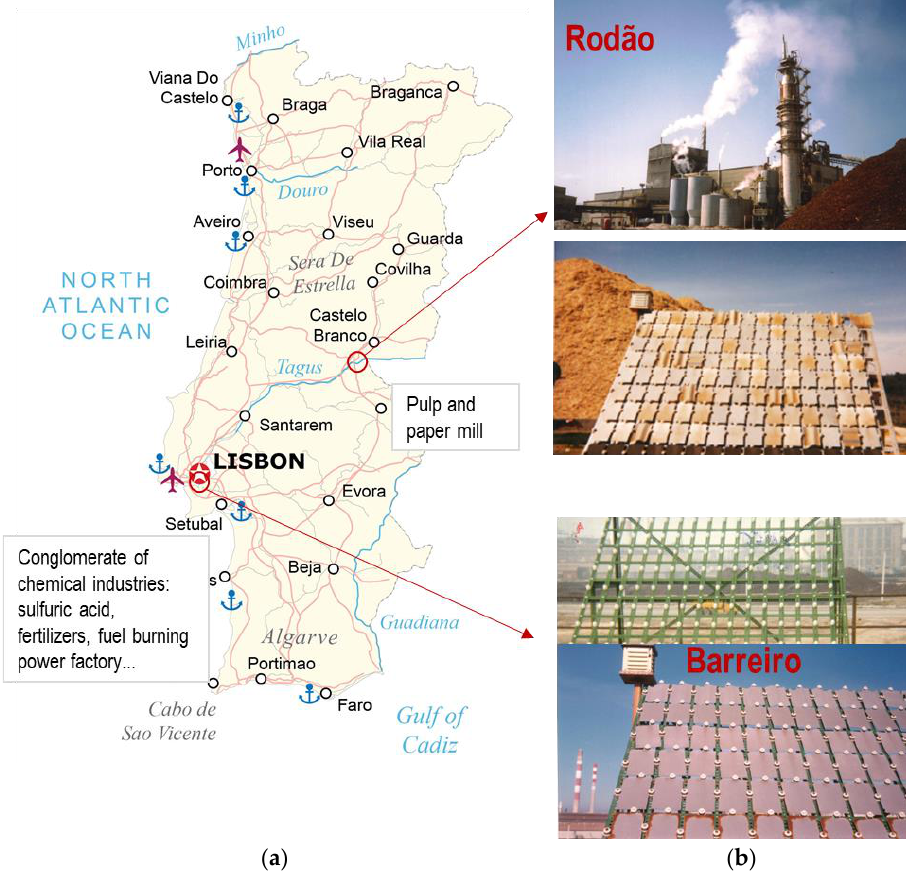
Figure 2. Exposure test sites. ( a ) Map of Portugal [27] with the locations of the test sites ( b ) Photos of the exposure sites: Rodão (top) and Barreiro (bottom), which show solid waste deposits of industrial waste near the racks and the coloration of the test specimens’ surfaces due to the deposition and accumulation of waste particles.